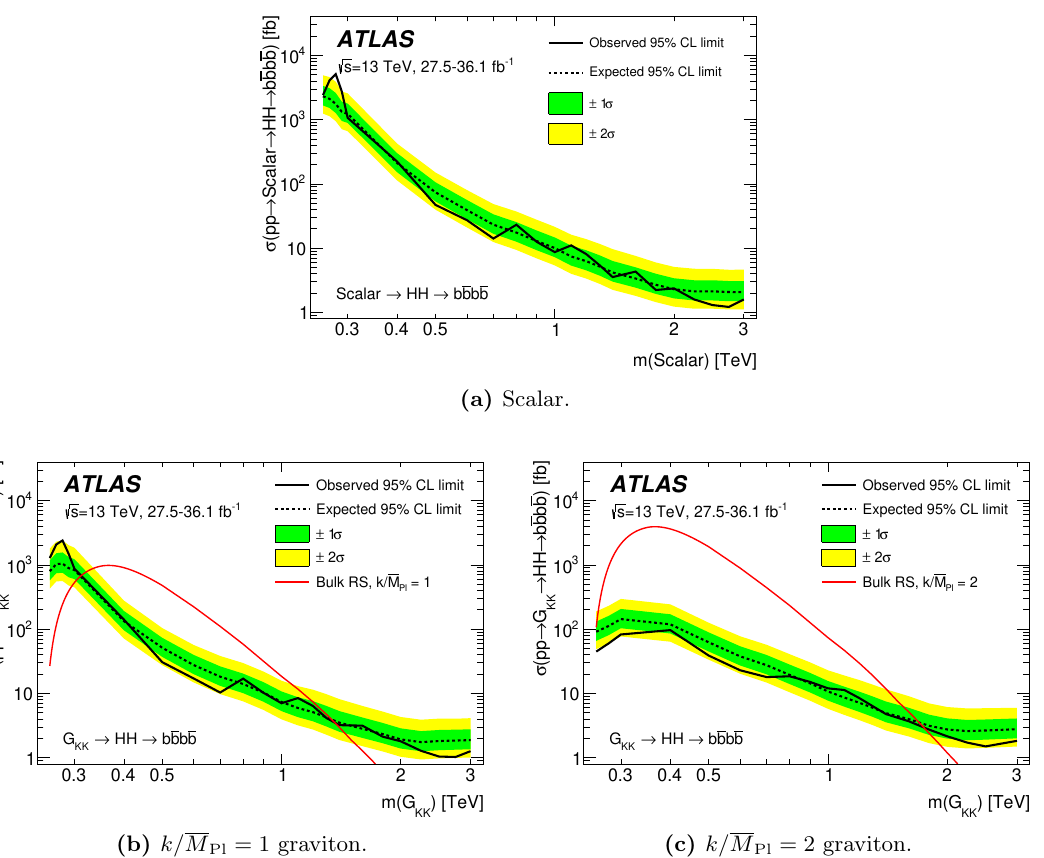
Figure 9. The observed and expected 95% CL upper limits on the production cross section times branching ratio for the (a) narrow-width scalar, (b) bulk RS model with k=M Pl = 1 and (c) bulk RS model with k=M Pl = 2. An additional (red) curve shows the predicted cross section as a function of resonance mass for each of the graviton models. The drop in the predicted cross sections for masses below m ( G KK ) = 350 GeV is due to a sharp decrease in the ( G KK ! HH ) branching ratio.